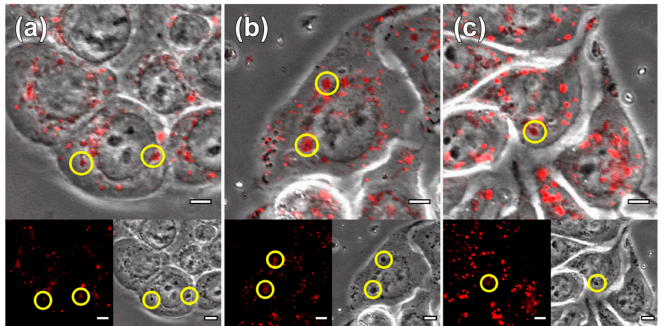
Figure 8. Internalization of Fe 3 O 4 nanoparticles, ( a ) pure MGT-35 ( b ) and MGT-35-FU ( c ) by HT29 cells. Cells were incubated with 0.1 mg/mL nanoparticles for two days. The nanoparticles are visible due to the high contrast provided in the transmission channel (low right inset) The lysosomes of the cells were labelled with lysotracker (red dots) (low left inset). The main image corresponds to the overlay of the fluorescent (red) and transmission channel. The yellow circles mark the overlap of nanoparticles and lysosome. The scale bar represents 5 µ m.